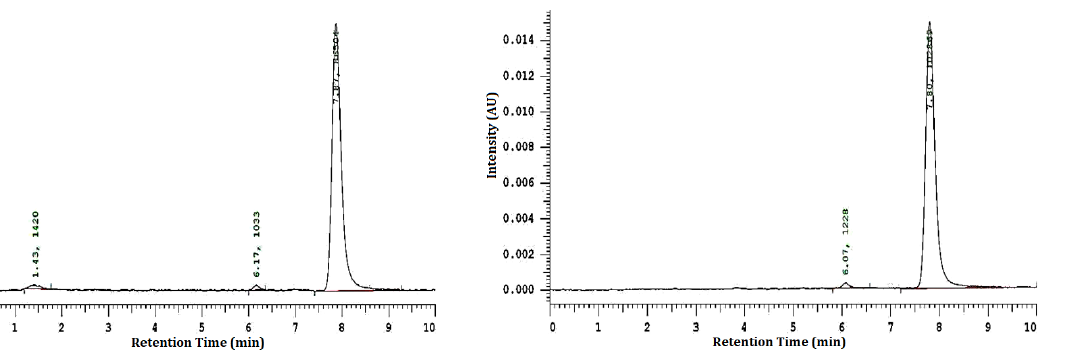
Figure 2. The results of bidimensional TLC under UV 254 nm (a) eluted with n-hexane-ethyl acetate (9:5) (b) eluted with cyclohexane-chloroform (1:4)